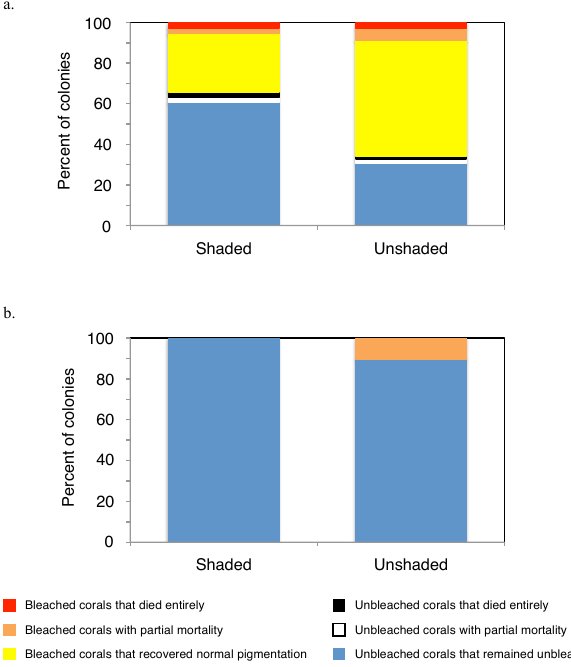
Figure 6. Recovery results for shaded vs. unshaded (a) Diplo- ria labyrinthiformis ( n = 38 and n = 171 for shaded and unshaded colonies, respectively) and (b) Colpophyllia natans ( n = 50 and n = 19 for shaded and unshaded colonies, respectively) from 2010 to 2011. Also refer to Table